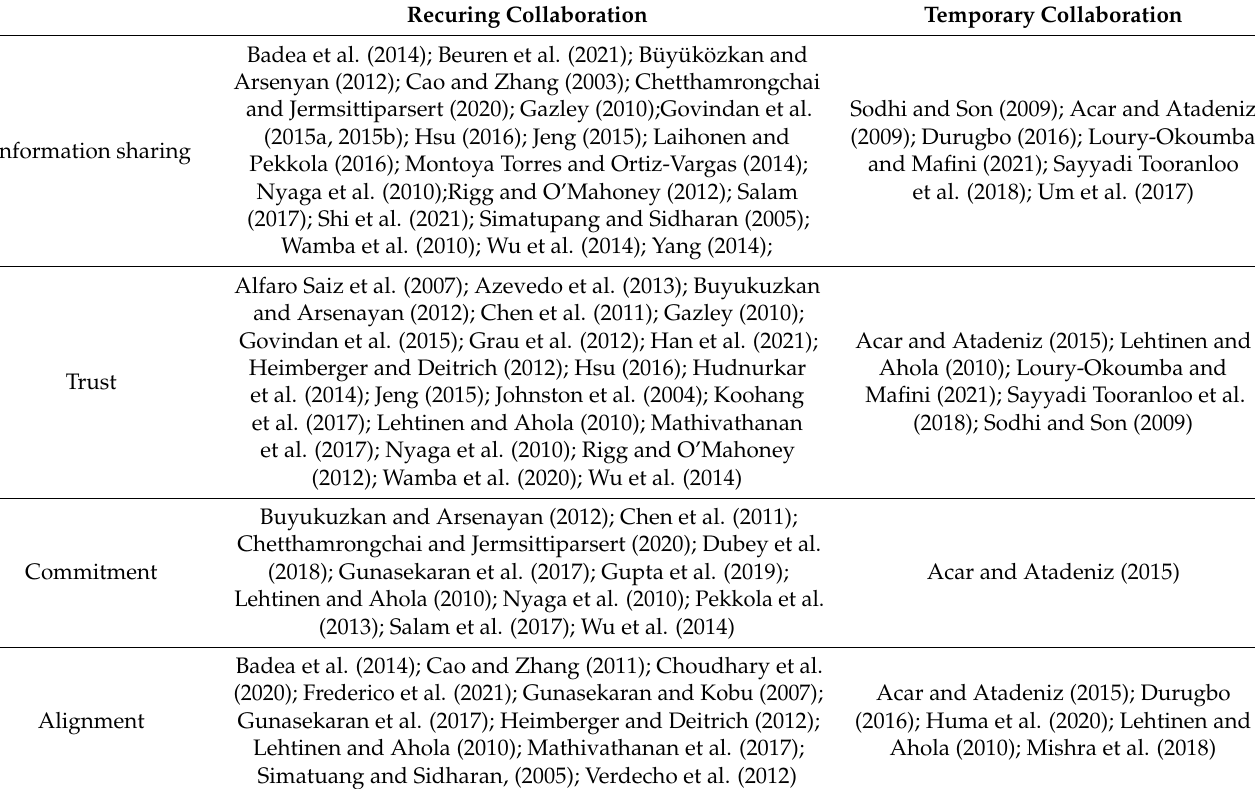
Table 5. The main performance determinants in literature divided by